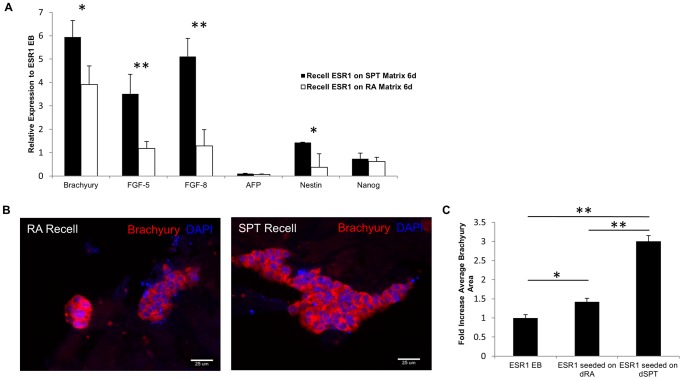
Gene and protein expression of the seeded EB constructs after 6 days of culture.(A) qRT-PCR result at day 6 to depict gene expressions related to early gastrulation. The expression level is normalized to native ESR1 EB at day 6. Higher early differentiation markers –Brachyury, FGF5 and FGF8 were found on ESR1 seeded on dSPT EB scaffold. VE gene – AFP and pluripotency gene – Nanog are downregulated on both seeded constructs compared to native EB. Neuroectoderm marker – Nestin was upregulated on seeded dSPT EB scaffold but downregulated in seeded dRA EB scaffold. (B) Brachyury protein expression was investigated and confirmed by IHC – representative images showing higher cell numbers found positive for Brachyury in ESR1 seeded on dSPT EB scaffold compared to dRA EB scaffold. (C) Cell number area positive for Brachyury were measured and compared among ESR1 seeded on dSPT, dRA EB scaffolds and native ESR1 EB and average Brachyury immunoreactive area was significantly greater on ESR1 seeded on dSPT scaffold. All values are mean ± SD; p<0.05 (*), P<0.01 (**), n = 3, represents individual seeded EBs in 3 experimental repeats.